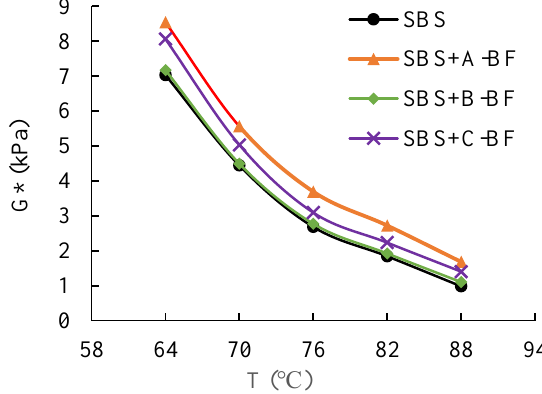
Figure 5. Results of the complex modulus.